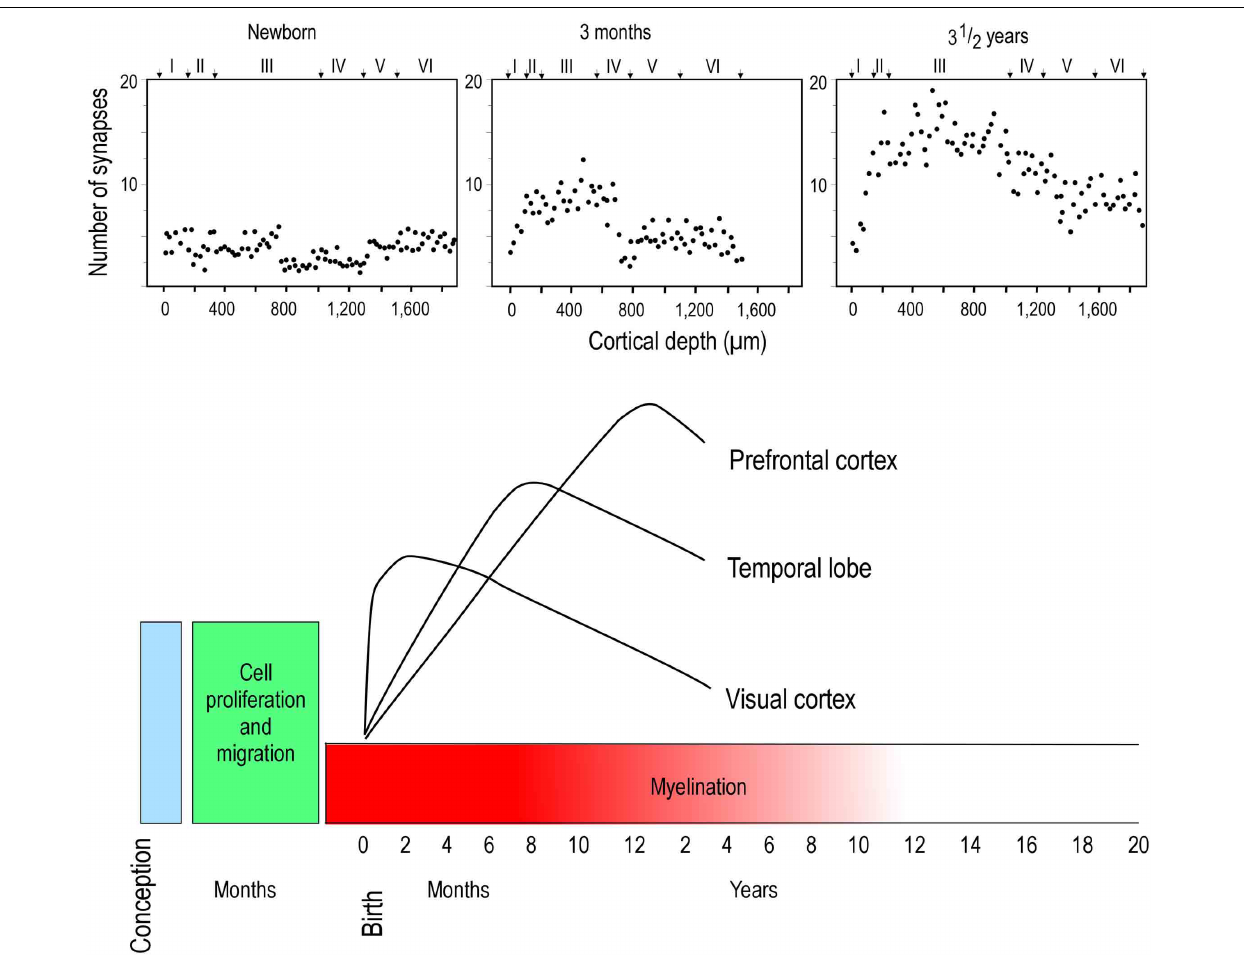
FIGURE 2 | Hierarchical synaptogenesis. Plots illustrating the density of synapses per 100 μ m of cortical neuropil in human left middle frontal gyrus in the newborn, 3 month old and in the three and a half year old postnatal brain. Note that the maximum synapse density at three and a